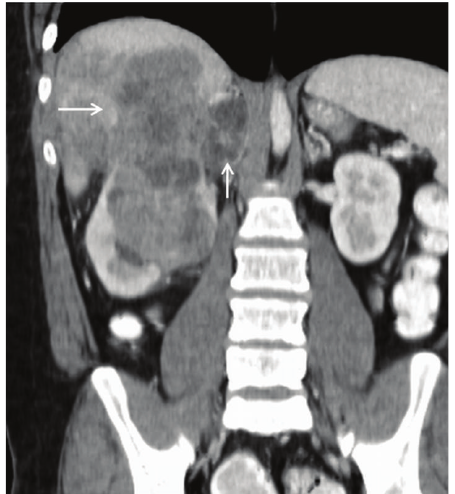
Figure 3: Coronal reconstructed CT image shows large lobulated mass of heterogenous attenuation invading the right liver (horizontal arrow). The right adrenal gland is expanded and completely replaced by the tumor (vertical